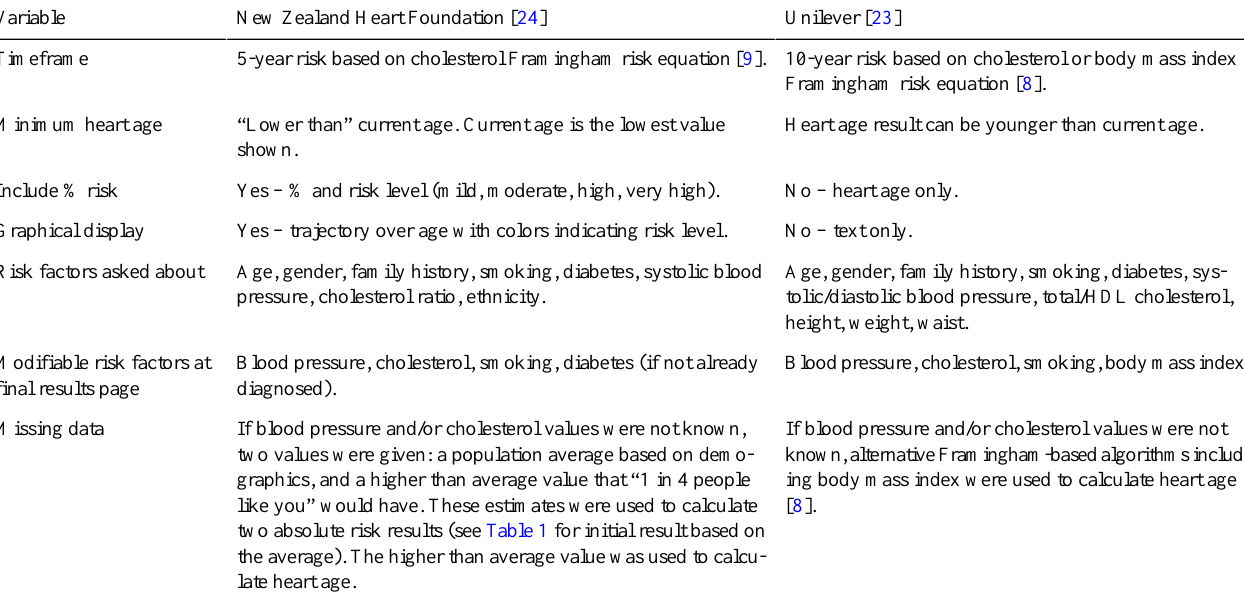
Table 2. Main differences between the two heart age